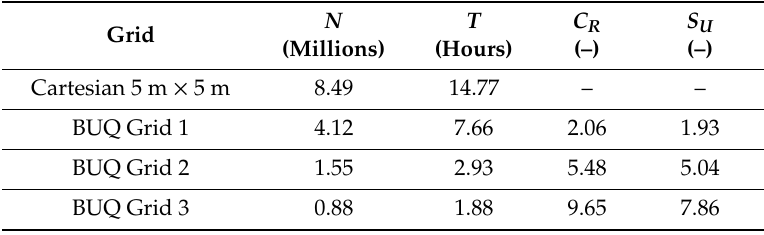
Figure 15. Multiresolution grids: from left to right BUQ Grid 1, 2 and 3. Table 3. Characteristics of simulations, compression rates C R and speed-ups S U for the different BUQ grids adopted.